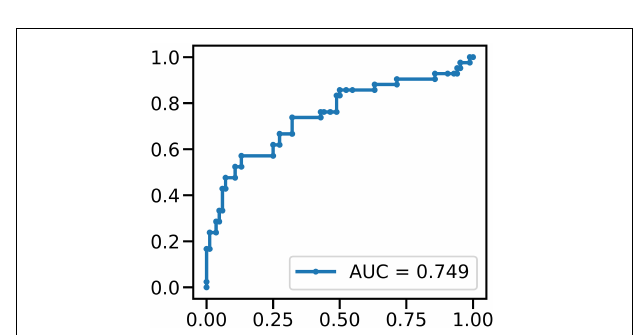
FIGURE 8 | The result of MERF to classify between FOG-epochs and non-FOG-epochs: in a total of 126 epochs (containing 42 FOG epochs), STN LFP band power features showed above-chance performance ( p < 0.01, permutation test) in identifying FOG